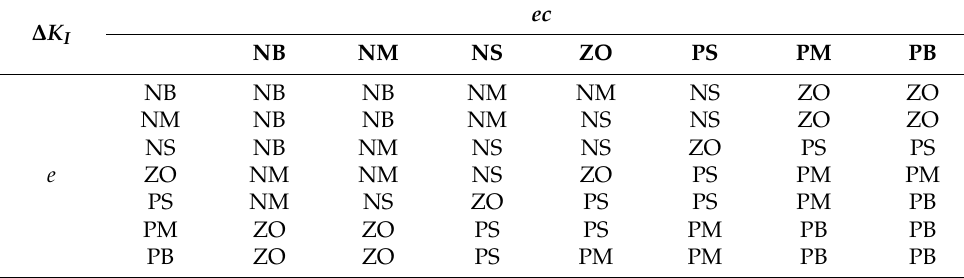
Table 2. ∆ K I fuzzy control rules.